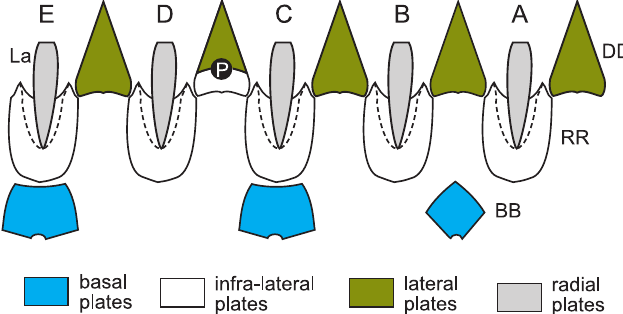
Fig. 11. Thecal plates of blastoids. A–E, Carpenter’s (1884, 1891) ambula- cra; BB, basals; DD deltoids; La, lancets; P, periproct; RR, radials; white plate below periproct in CD interambulacrum is one of the extra deltoids. Dashed lines are radial sinuses for ambulacra. For plate homologies see Table 2. Table 2. Plate homologies in blastozoans with tetraserial ambulacra; in brackets number of plates. Extraxial- Hemicosmitoids axial theory